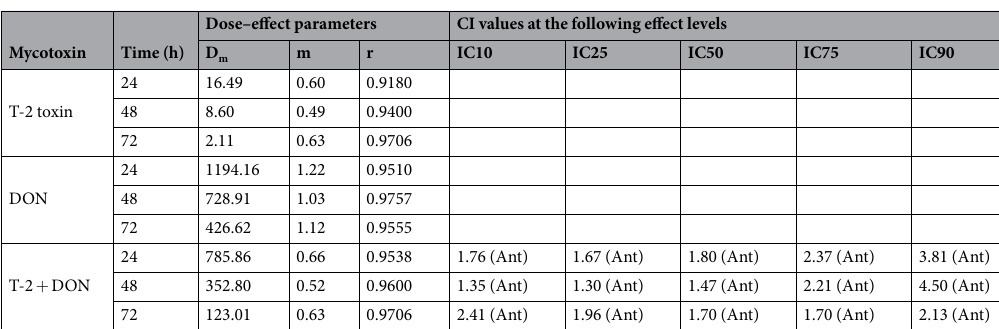
Table 3. Dose–effect relationship parameters and mean combination index (CI) values of T-2 toxin or DON alone or in combination on L-02 cells. The parameters m, D m , and r are the slope, antilog of the x-intercept, and the linear correlation coefficient of the median-effect plot, which signifies the shape of the dose-effect curve, the potency (IC50), and the conformity of the data to the mass-action law, respectively. IC10, IC25, IC50, IC75, and IC90 are the doses required to inhibit proliferation by 10%, 25%, 50%, 75% and 90%, respectively. Ant indicates antagonistic effect.